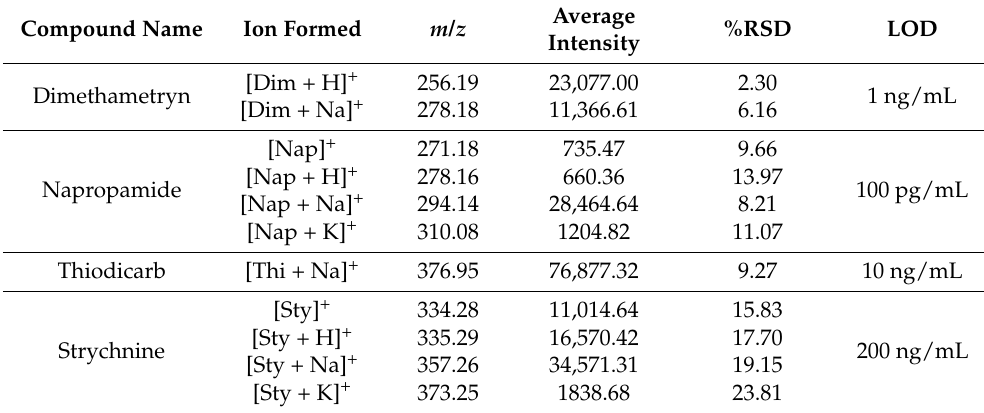
Figure 4. The effect of reducing agents N 2 H 4 ·H 2 O and NaBH 4 on the performance of FeNi MANPs as SALDI-MS substrates for the detection of different poisons: dimethametryn, napropamide, thiodicarb, and strychnine. Table 2. Poisons detected, ion formed, m / z , average intensity, %RSD, and